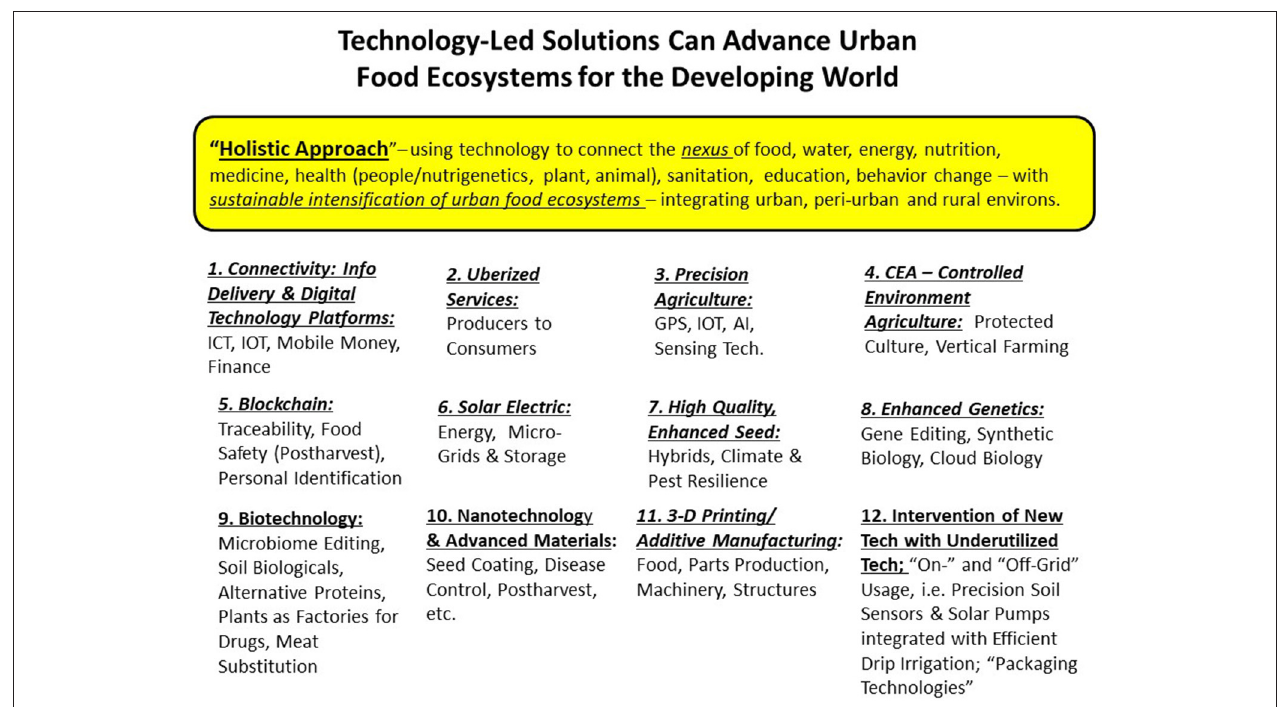
FIGURE 2 | Twelve innovative technology platforms to sustainably intensify urban food ecosystems (UFEs) of the developing world.